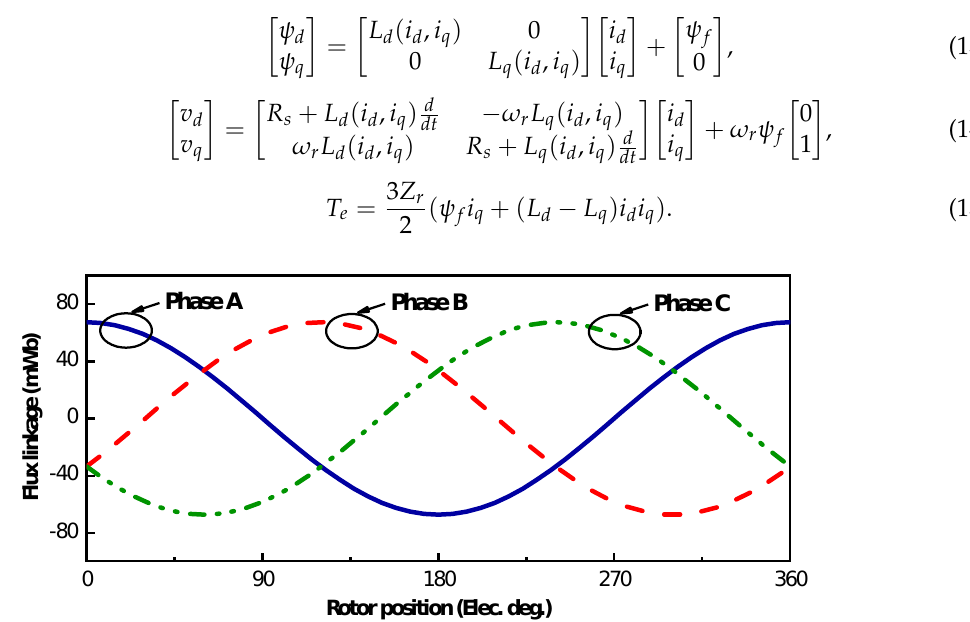
Figure 7. Open-circuit three phase flux linkage. The other detailed parameters are given in Table